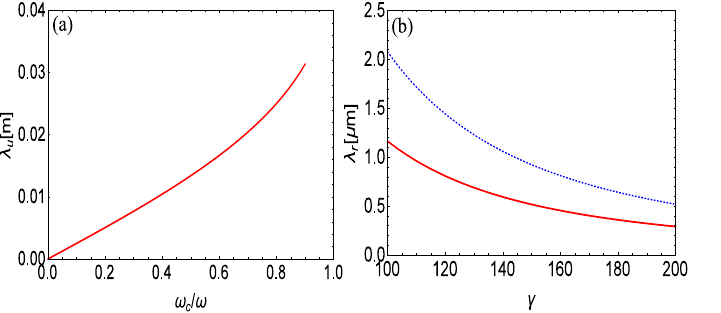
(cid:34) (cid:35) 2 n K u f 2 vs. microwave power, n = 1 (solid line), n = 3 (dotted line), b , n 1 + K 2 u 2 ω c for different values of the microwave power, ω